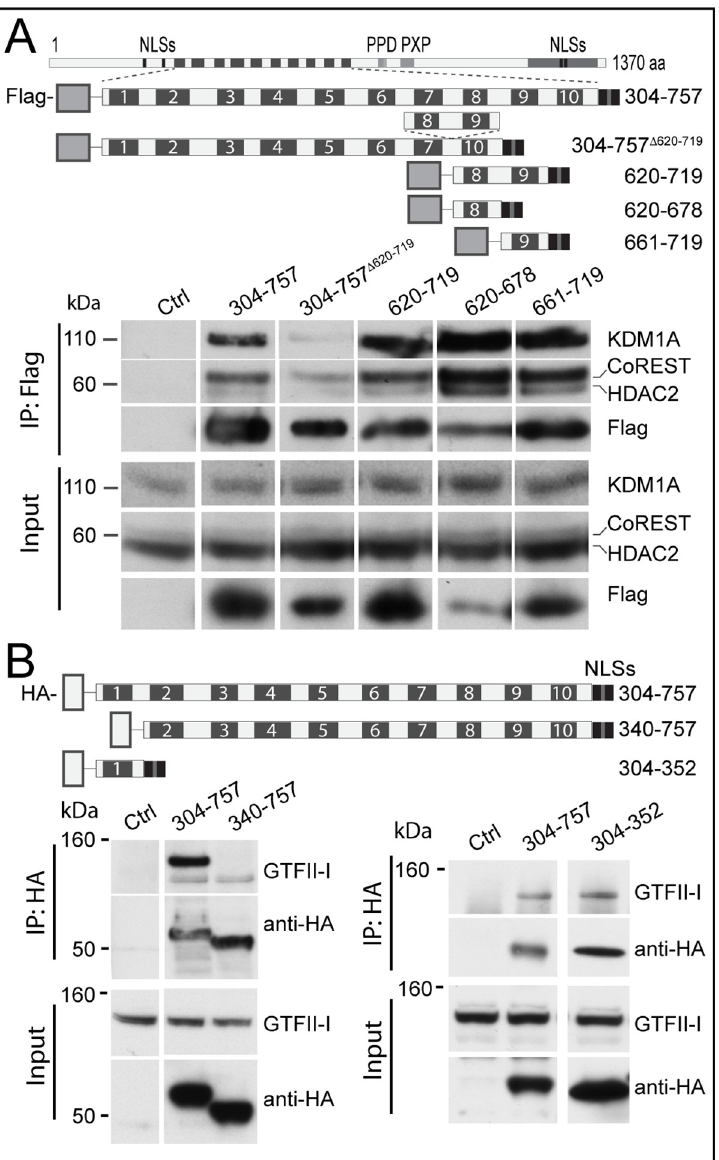
Fig 3. The ZMYM3 zinc finger domains mediate its interactions with the CoREST complex. (A) Pulldown of members of the CoREST complex by FLAG-tagged fragments of ZMYM3 zinc finger domains. The schematic shows the domain architecture of ZMYM3 and the Flag tagged fragments. Lysates from cells transfected with empty vector are show as controls. The input equals 3% of the total lysate. Levels of the endogenous KDM1A, HDAC2 and RCOR1/ CoREST proteins relative to each other were consistent in all experiments and are shown as control of each other in input lysates. The expression of fragment 620–678 (corresponding to zinc finger 8) was reproducibly lower than that of the rest of the fragments, including the fragment corresponding to zinc finger 9, as shown. Antibodies used to visualise the proteins were Rabbit anti-CoREST, Rabbit anti-HDAC2, Rabbit anti-KDM1A (LSD1), Goat anti-Rabbit IgG Peroxidase and Mouse anti-FLAG M2 Peroxidase. The size of the molecular standards is indicated in kDa. (B) Pulldown of GFII-I co-immunoprecipitated with HA-tagged fragments of ZMYM3 zinc finger domains. As in A, the schematic shows the fragments identified by the corresponding amino acids. Antibodies used were Rabbit anti-GFII-I, Goat anti-Rabbit IgG-HRP and Rat anti-HA Peroxidase. The same results were observed for A and B in three independent pull-downs